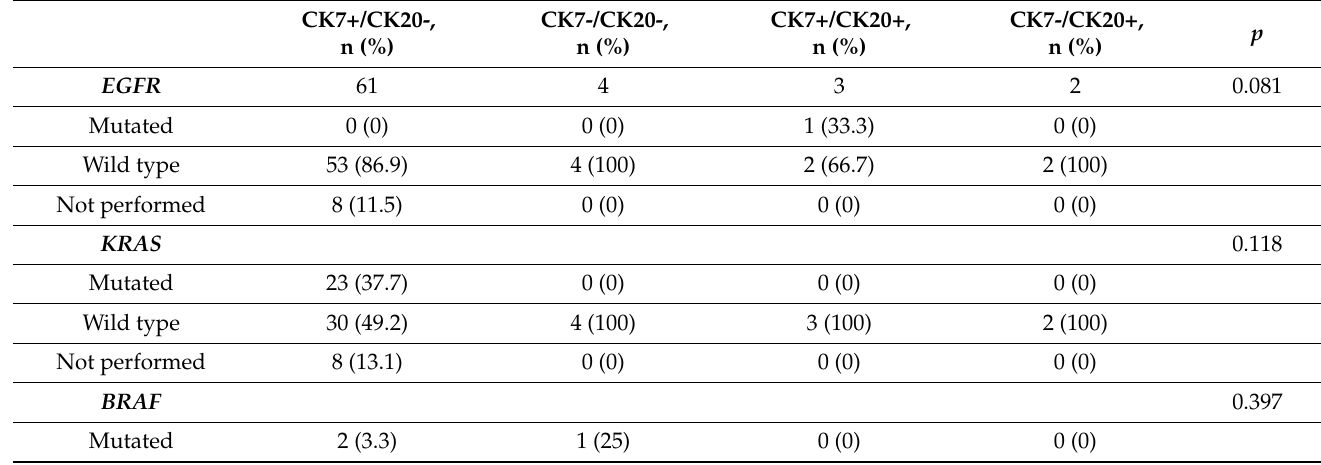
Table 4. Molecular alterations between CK7/CK20 groups in TTF-1 negative